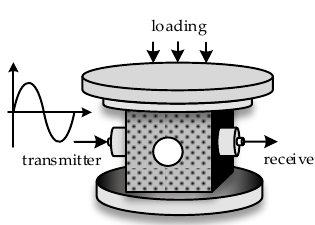
Figure 3. Specimens and sensor distribution.